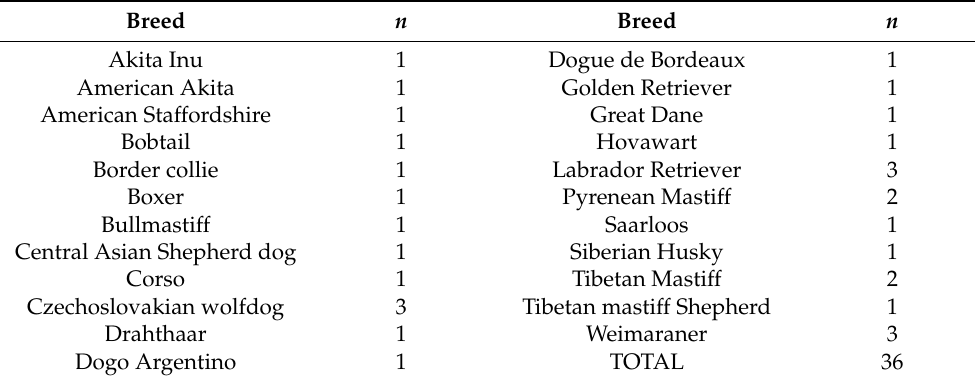
Table 3. Distribution of canine breed in the mesomorphs group.